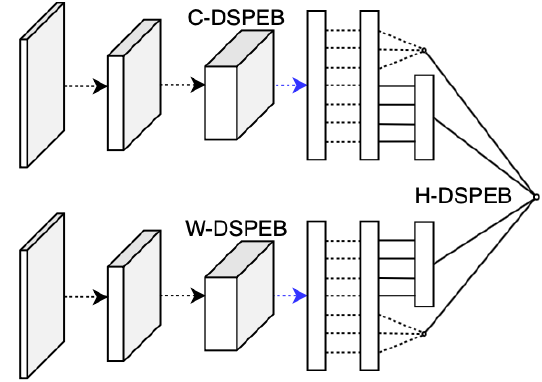
Figure 3. The neural architecture of Hybrid-DSPEB combining the pretrained C-DSPEB and W-DSPEB models. The blue arrows represent non-parametric connections (flattening layer). Dotted lines represent pre-trained layers that are frozen during H-DSPEB